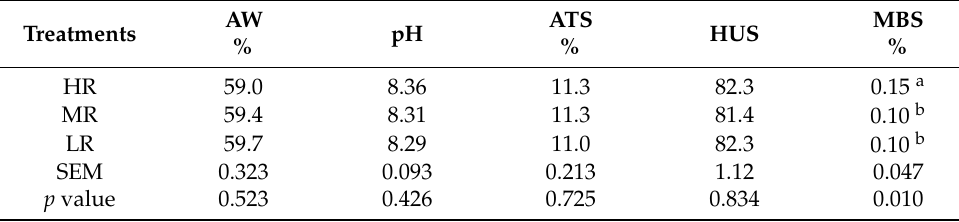
Table 5. Effect of ω -6/ ω -3 ratio on egg albumen quality of laying hens. Treatments